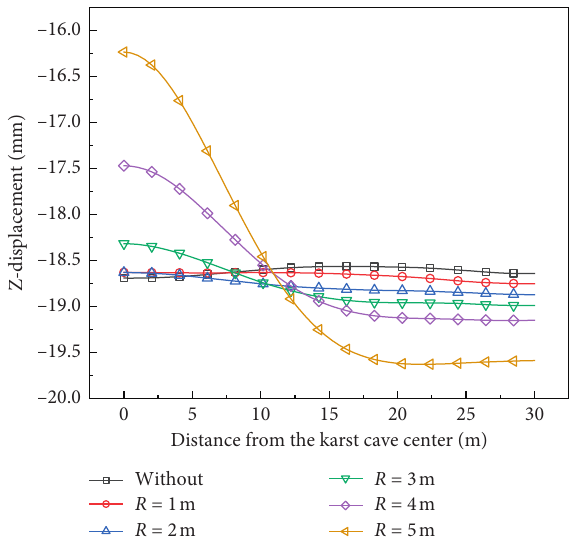
Figure 10: Z -displacement curves of the tunnel bottom with varying sizes of the karst